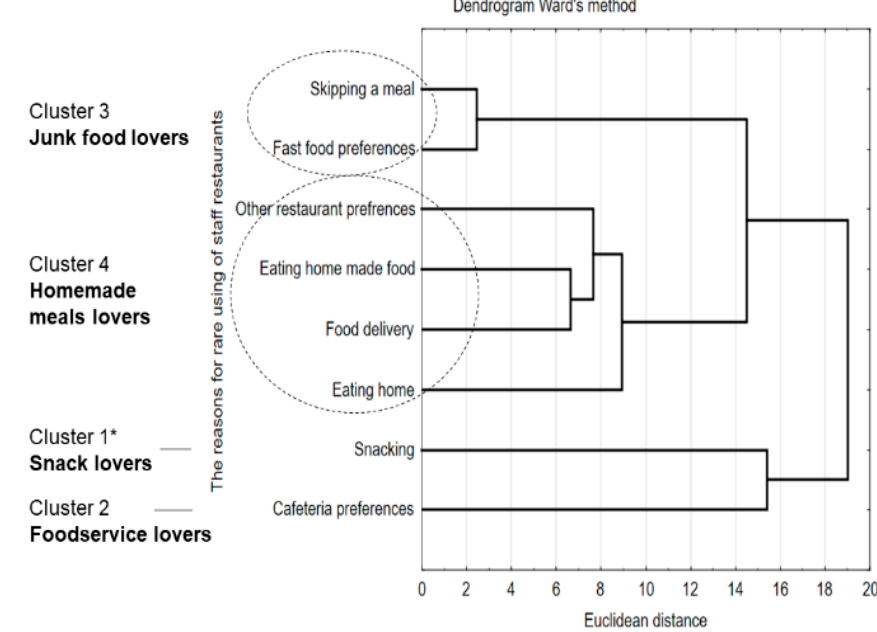
Figure 1. The analysis of consumer profile with the reasons for not using the staff canteens and the division into groups of reasons; * clusters were numbered according to the frequency of indications.